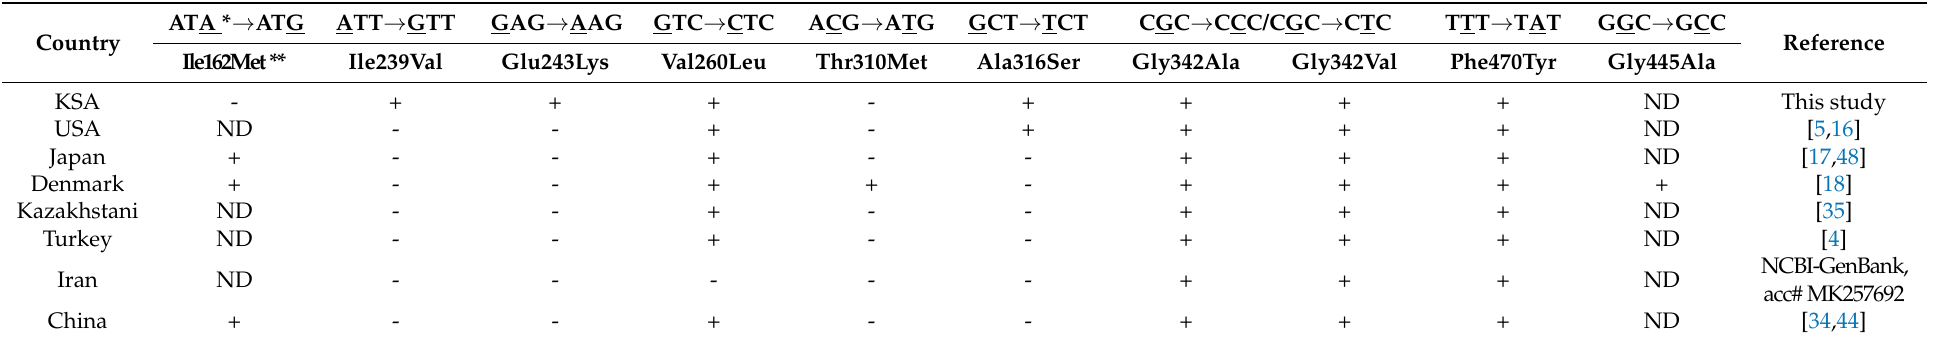
Table 7. Nonsynonymous SNPs in Ace gene, causing amino acid changes in AChE protein, associated with insecticide resistance in house flies from Saudi Arabia and other